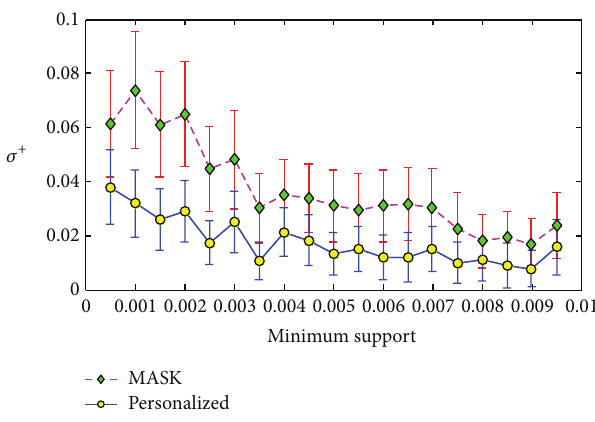
Figure 5: Frequent itemset added ration 𝜎 + versus minimum support on